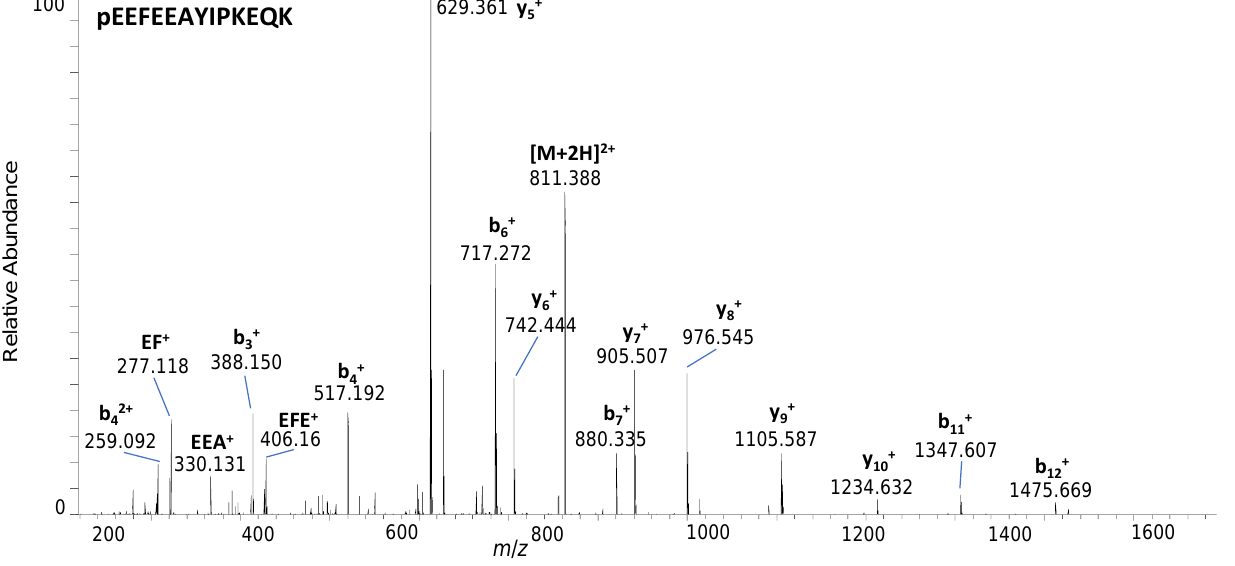
Figure 4. Product ion mass spectrum of unlabelled hGH 29-41 obtained after incubation of hGH in skin S9 mix for 24h; precursor selected at m/z 811.391 (z = 2).